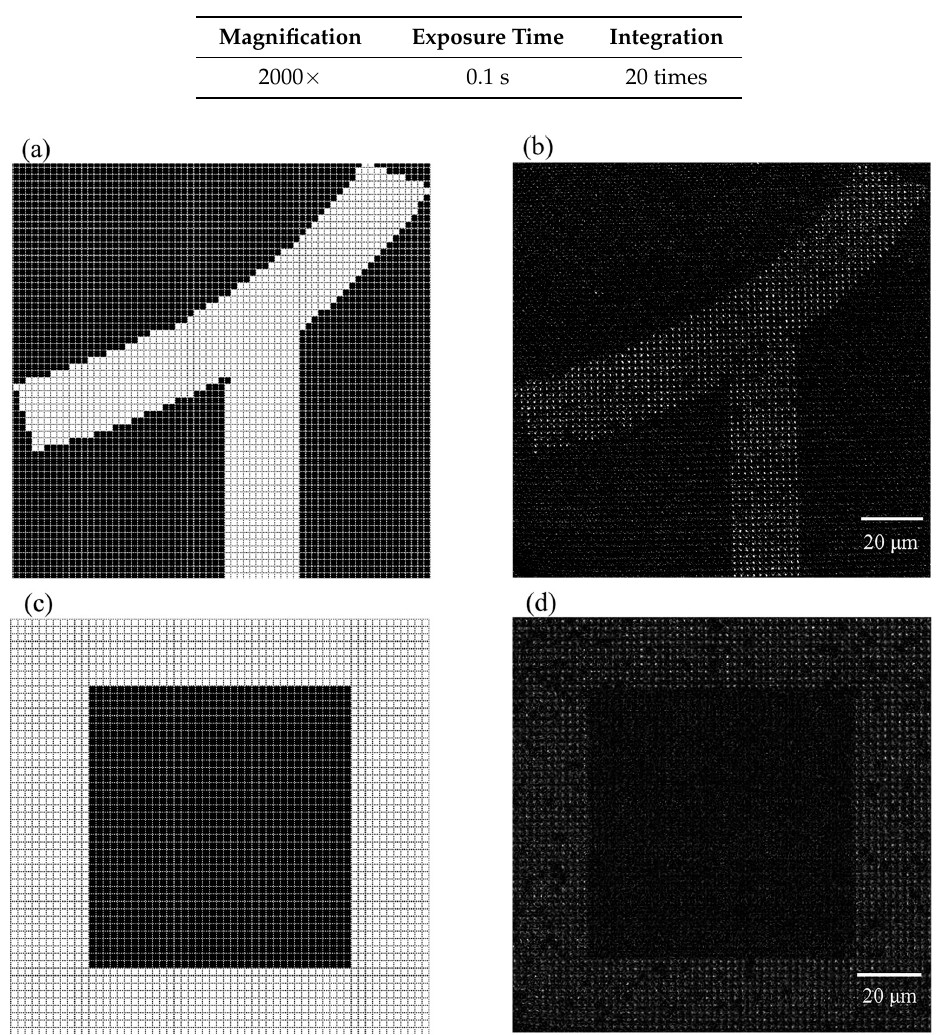
Table 2. Conditions for the magneto-optical (MO) micrograph.